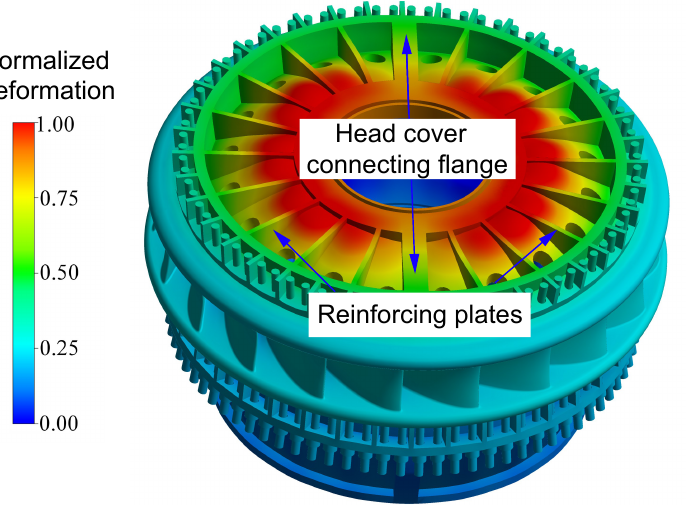
Figure 14. The deformation distribution of the non-rotating structures (cross-section). The flow-induced stresses of the non-rotating structures of the pump-turbine unit at different moments during turbine start-up also present a similar distribution, with the maximum stresses concentrated at the stay ring. The flow-induced stress distribution during turbine start-up normalized with the maximum stress value of the stay vanes (Figure 15).